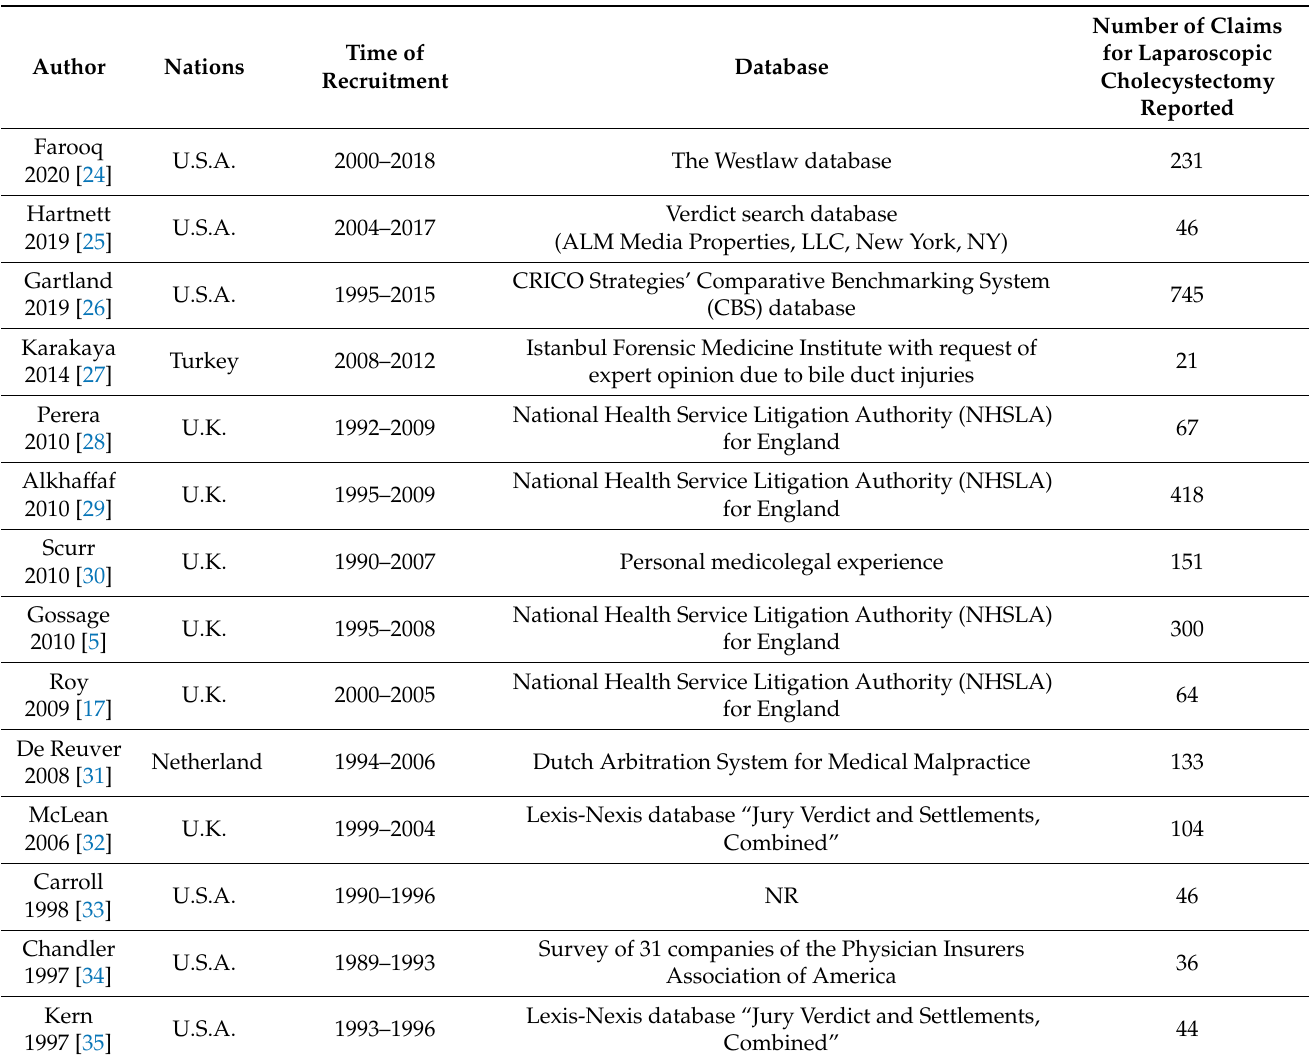
Table 1. Included